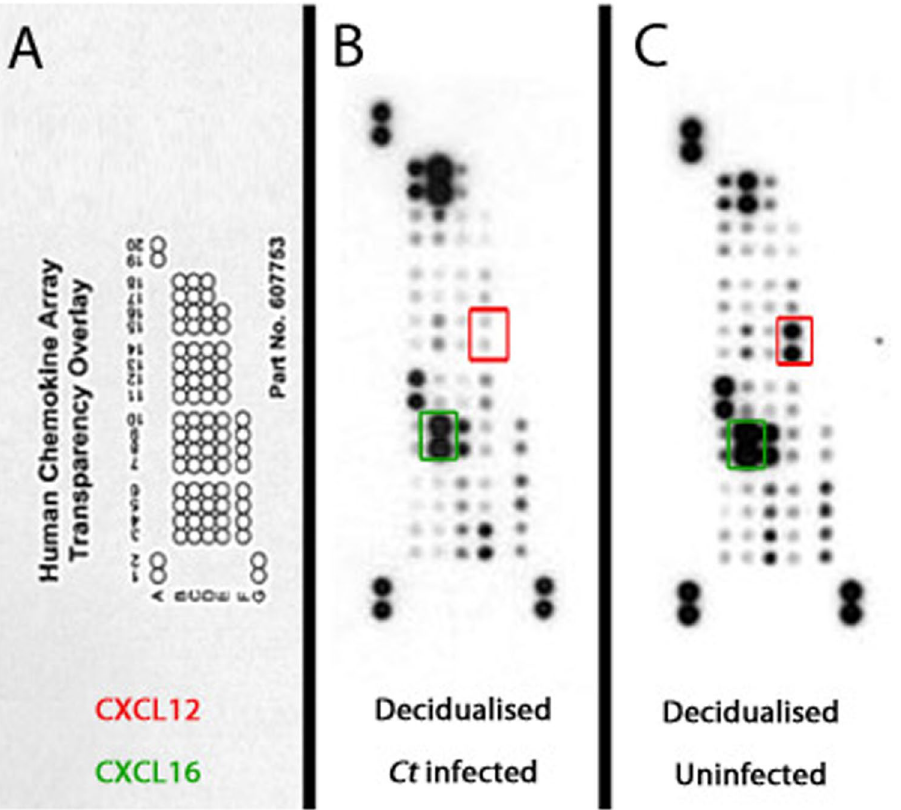
Figure 3. Chemokine proteomic array of 31 chemokines on pooled cell supernatants from Ct infected and uninfected decidualised cells. Each chemokine is represented by a dot. ( A ) Ct infected decidualised ESC secreted chemokine profile, demonstrating ESC secrete all 31 chemokines. ( B ) Uninfected decidualised ESC secreted chemokine profile that is altered compared to Ct infected ESC (n =